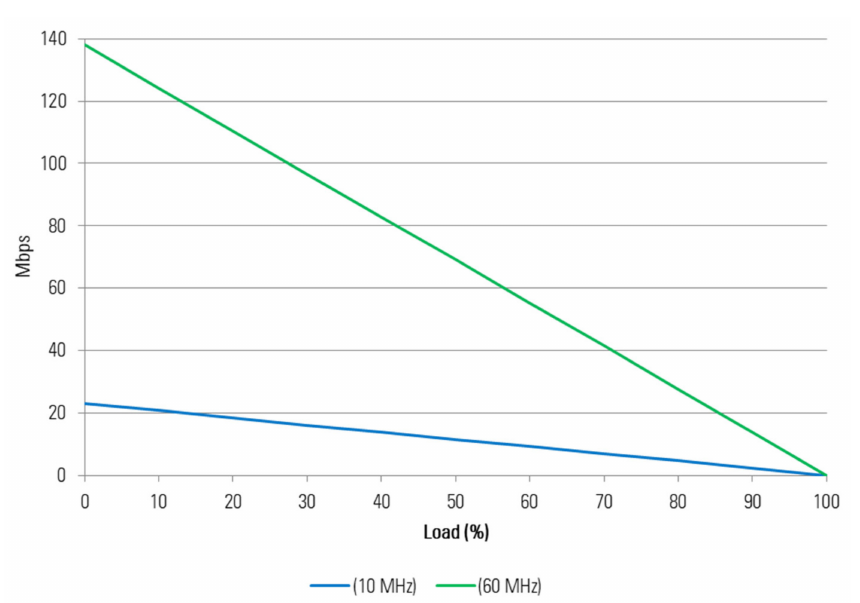
Figure 4. Throughput per